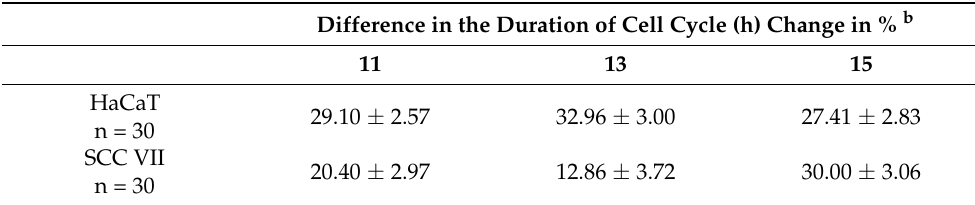
Table 5. The effect of compounds 11 , 13 and 15 on the generation times of HaCaT and SCC cells a . Difference in the Duration of Cell Cycle (h) Change in % b